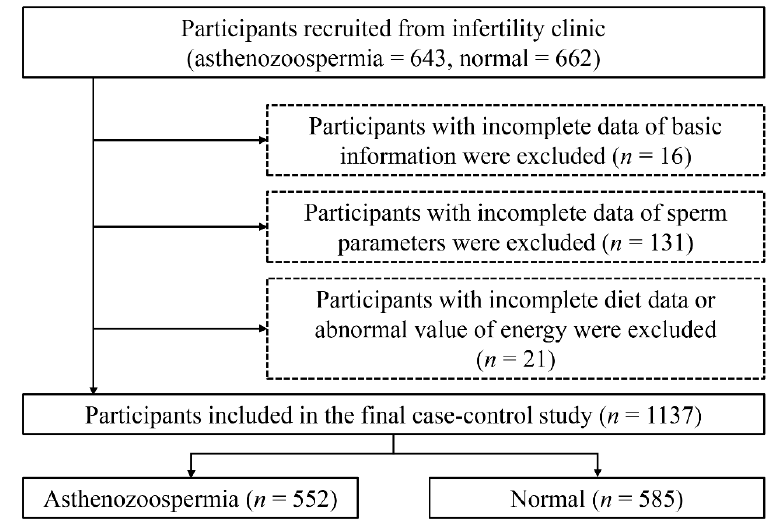
Figure 1. Flow-chart of the selection of participants.